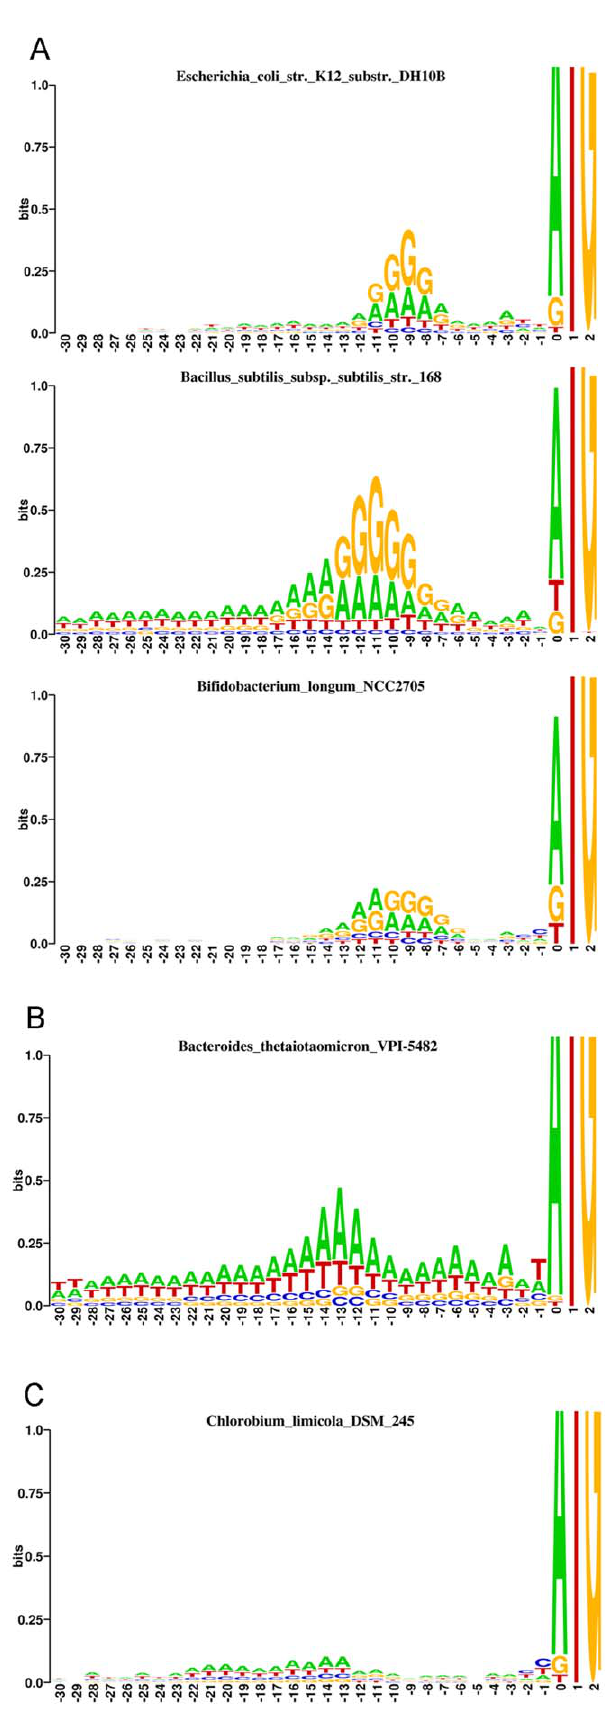
Figure 1. Sequence logo analysis of start codon upstream regions. A: Sequence logos showing the presence of SD sequence in some well known bacteria. Sequence logos of Bacteroidetes (B) and Chlorobi (C) demonstrate the lack of SD sequence. The position 0 represents the nucleotide position of start codon.